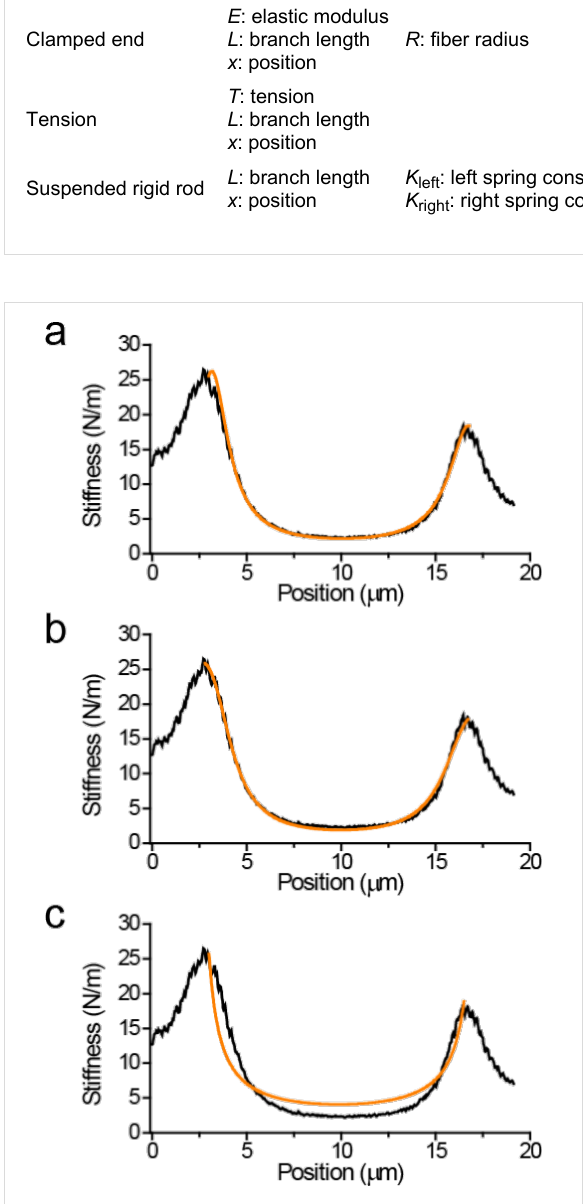
Figure 4: Curves described by equations for pinned end (a), clamped end (b), and tension (c) models fitted to the data. Values of the vari- ables used for fitting are listed in Table 1.